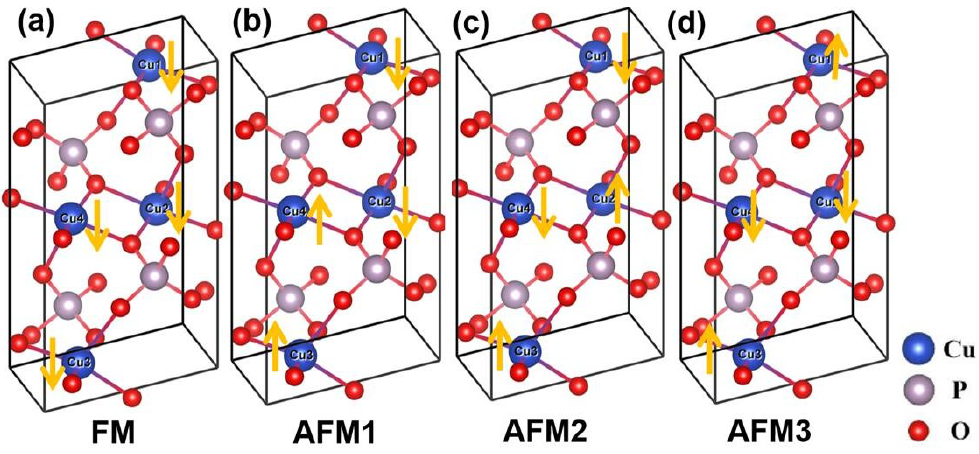
Figure 1. Optimized crystal structures for four collinear configurations of magnetic moments on Cu atoms in α -Cu 2 P 2 O 7 , one ferromagnetic (FM) and three antiferromagnetic (AFM). ( a ) FM; ( b ) AFM-1; ( c ) AFM-2; ( d ) AFM-3. Large blue, grey, and red balls denote copper, phosphorus, and oxygen atoms,